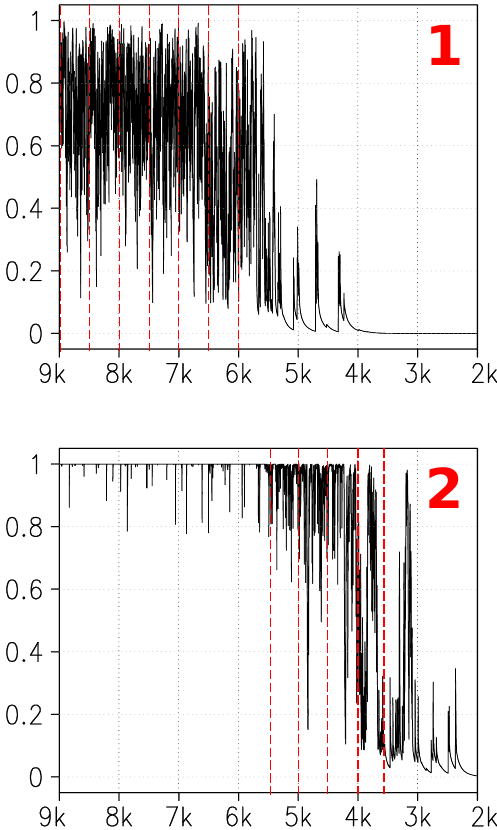
Fig. 3. Vegetation cover fraction in the transient PlaSim-VECODE experiment from 9k to 2k. Two single grid cells are shown, in- dicated as grid cells 1 and 2 in Fig. 2. The vertical dashed lines indicate the B values of the 20000yr long stationary PlaSim- VECODE-tr simulations used to construct RM1 (top) and RM2